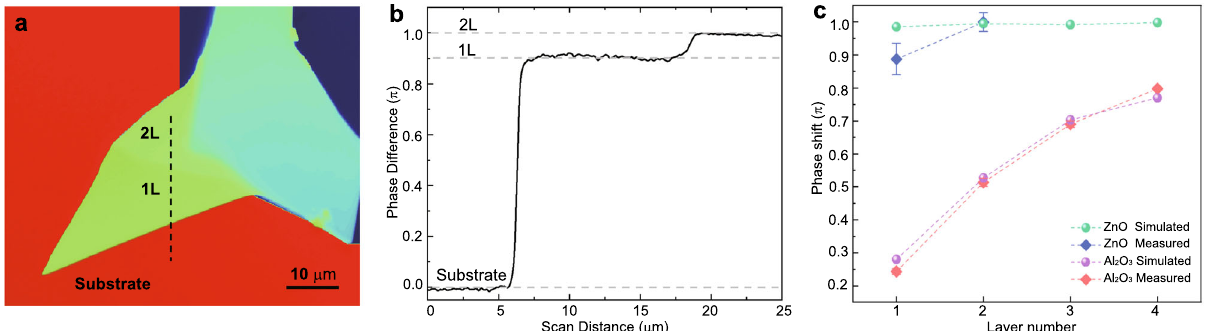
Fig. 2 Experimental demonstration of a giant π phase shift arising from an atomically thin MoS 2 sheet. a PSI image of a mechanically exfoliated MoS 2 fl ake on a ZnO/Si substrate. The thickness of the ZnO layer is 65 nm. Different colours represent different thicknesses of MoS L ” and “ 2 L ” are mono- and bilayer MoS 2 , respectively. b PSI measured phase difference versus position of 2 L and 1 L MoS 2 along the dashed line marked in ( a ), which depicts that (0.89 ± 0.048) π and (1 ± 0.028) π phase shifts can be achieved for mono- and bilayer MoS 2 sheets on the ZnO/Si substrate, respectively. c Statistical data of the phase shift values with error bars from PSI for 1 L, 2 L, 3 L, and 4 L MoS 2 samples on Al 2 O 3 -coated surfaces and 1 L and 2 L MoS 2 samples on ZnO-coated surfaces. For each layer number of MoS 2 , at least fi ve different samples were measured experimentally, and the error bars represent standard deviation of phase shift values in the characterization results, which arises from the inconsistent experimental